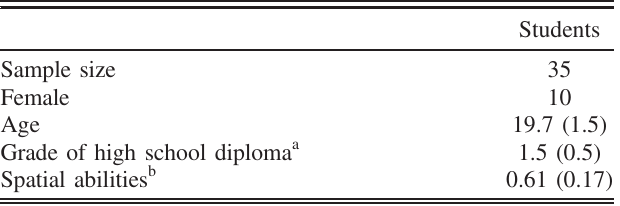
TABLE II. Summary of students ’ demographics (mean (cid:2) standard